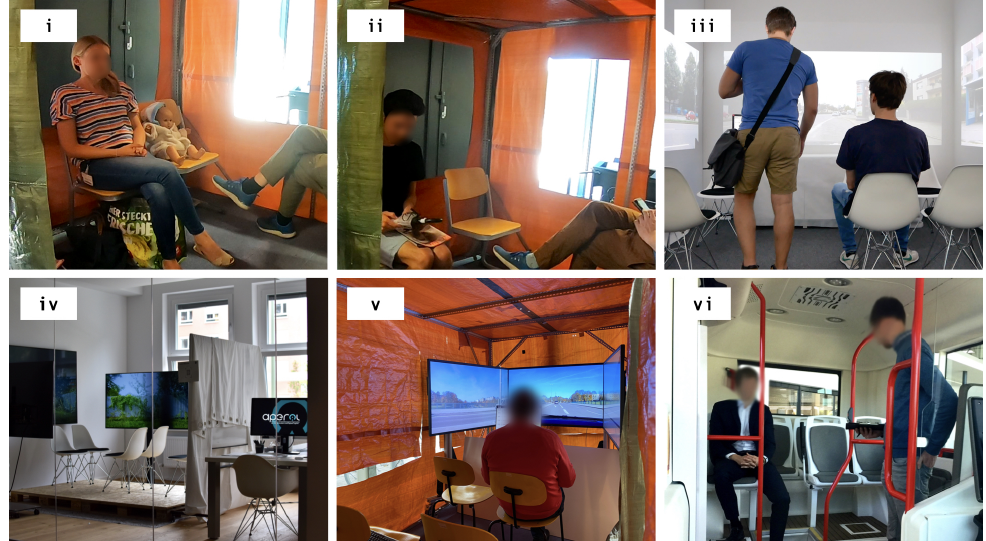
Figure 2. Examples of static interior mock-ups of (shared) AVs in combination with other prototyping methods. Images ( i , ii ) were taken from Schuß et al. [40], who used a tent-based setup in combination with a dynamic enactment simulation and physical items. Images ( iii – v ) show video-based simu- lation setups with different spatial mock-up components (chairs, walls, tent, whiteboard, wooden pellets) [10,30,46]. Image ( vi ) shows a high-fidelity interior of a shared